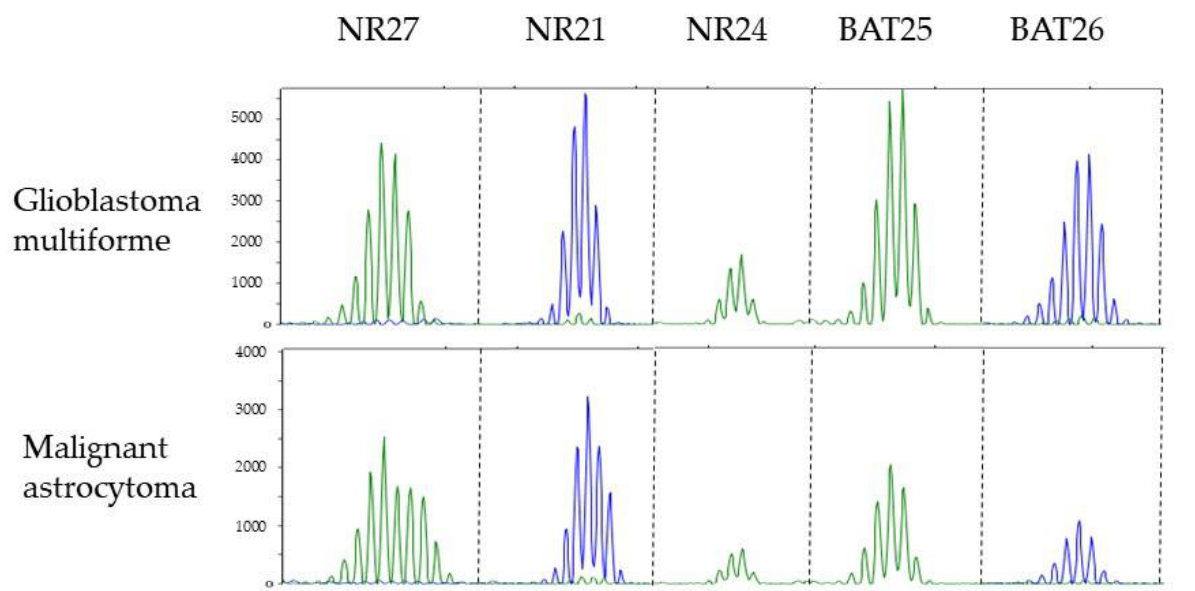
Figure 3. Electropherograms showing microsatellite profiles of five mononucleotide repeats markers (NR21, NR24, NR27, BAT25, and BAT26) in each tumor. A broader spectrum is observed in marker NR27 in the malignant astrocytoma.